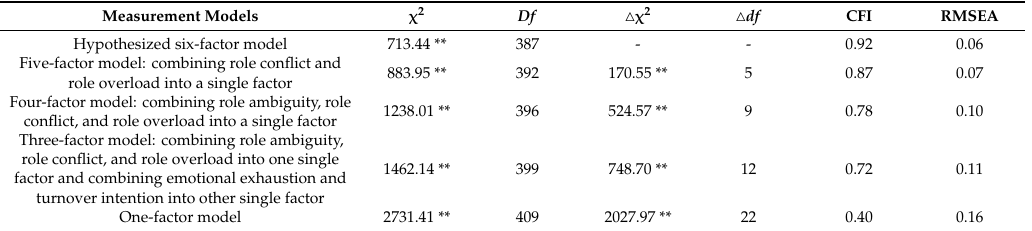
Table 3. Comparison of measurement